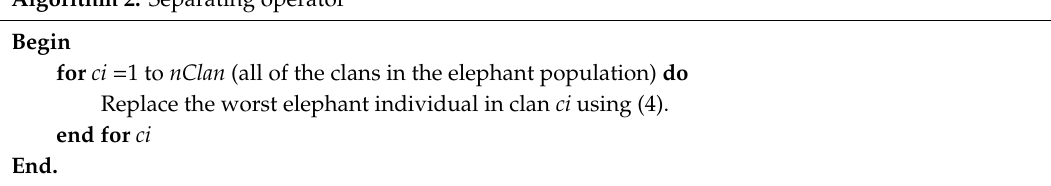
Algorithm 2: Separating